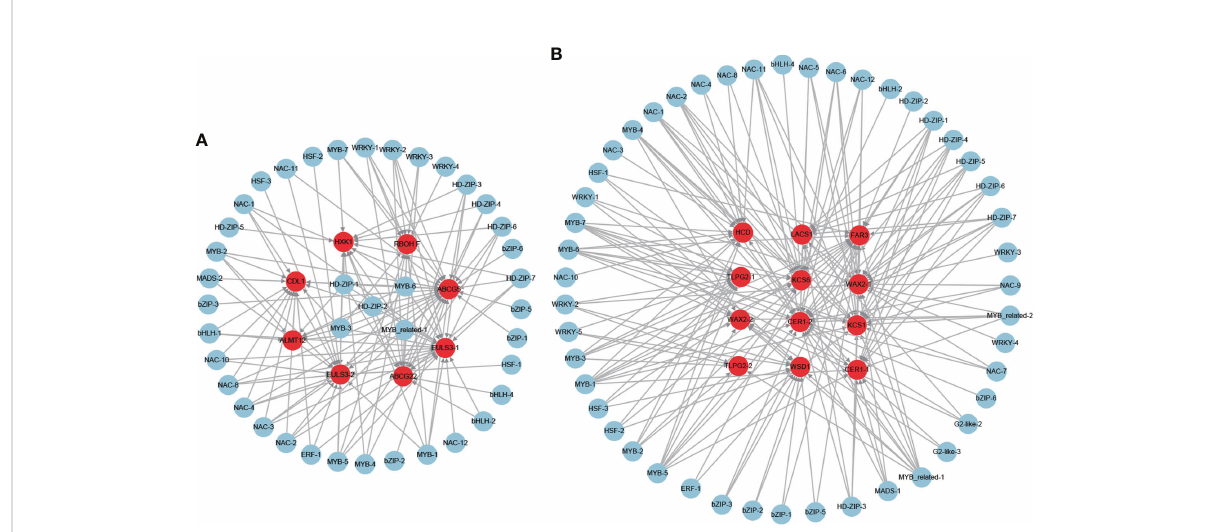
FIGURE 11 The regulatory network of stomatal closure (A) and cuticular wax biosynthesis and transport (B) genes from the core drought-resistant genes in